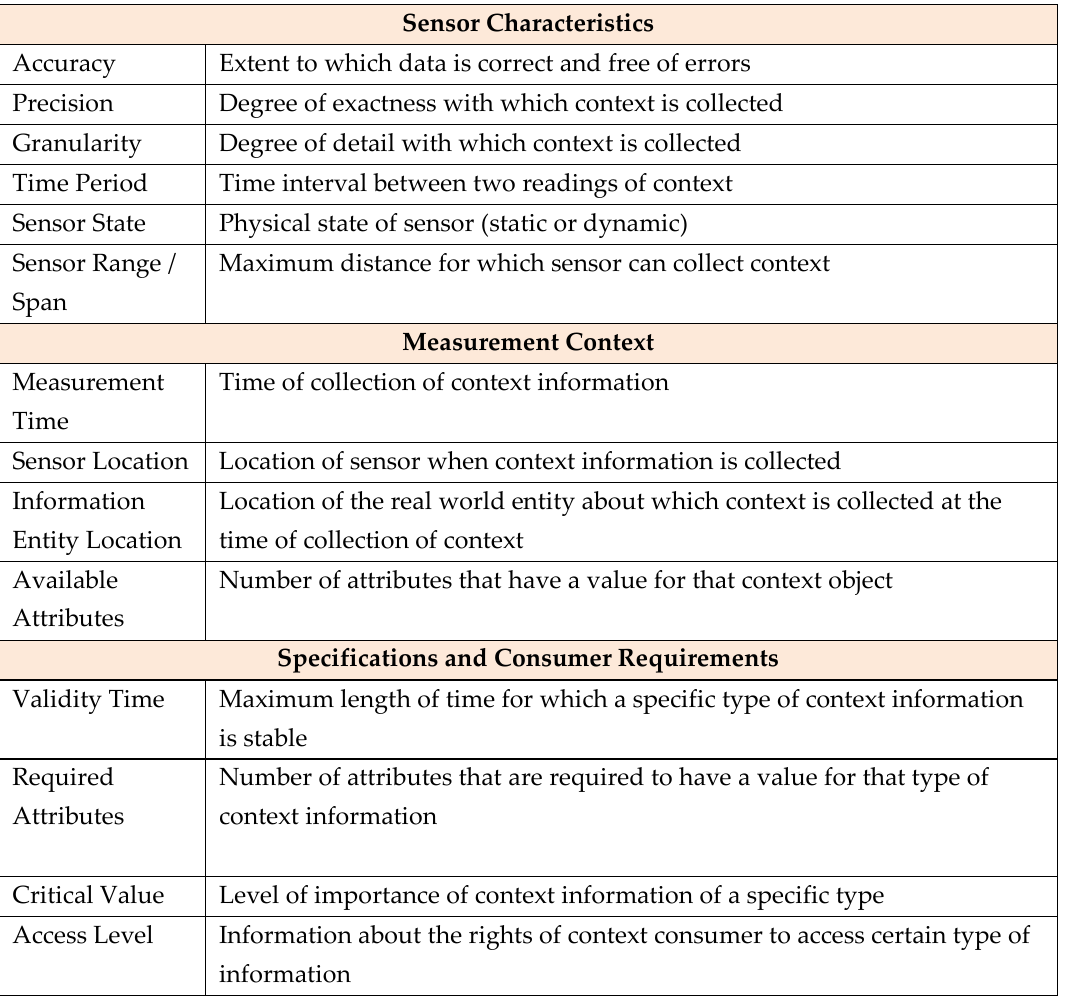
Table 2. Sensor characteristics, specification and consumer requirements [14].